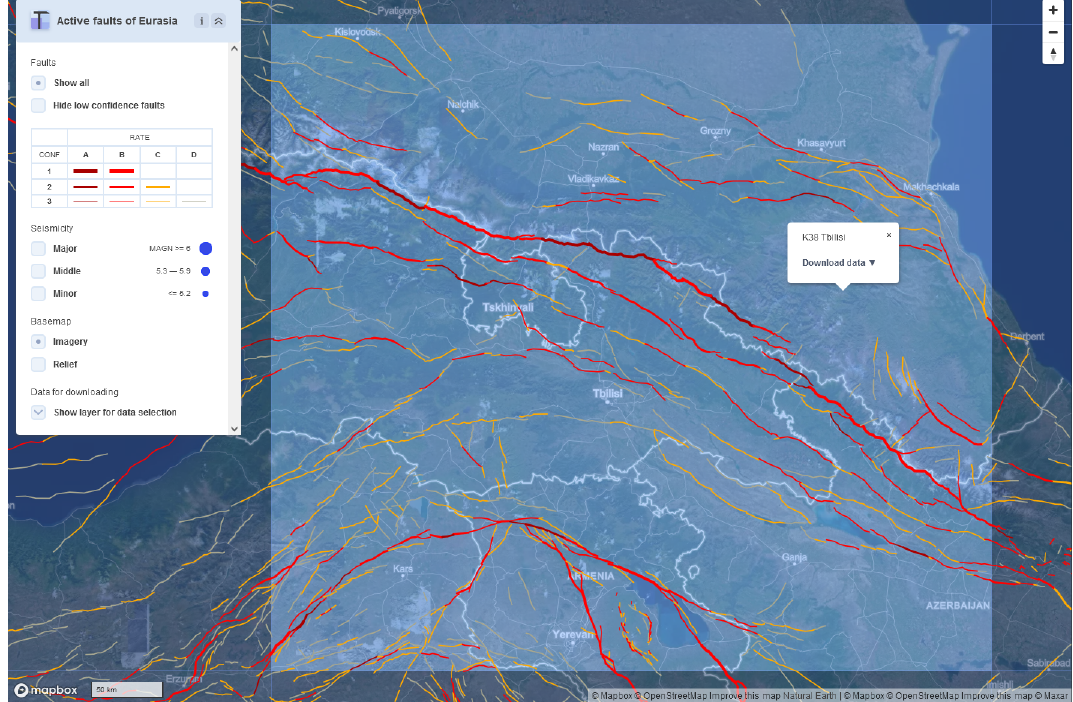
Figure 10. Representation of active faults in the Caucasus by the AFEAD web interface (http://neotec.ginras.ru/index/mapbox/database_ map.html, last access: 5 May